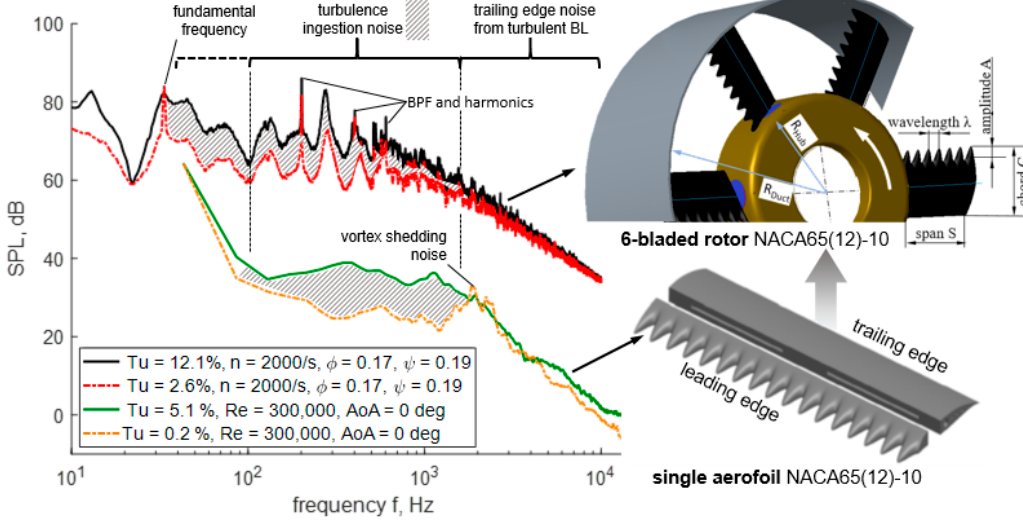
Figure 1. Juxtaposition of the sound pressure level SPL (Equation (6)) of a single NACA 65(12)-10 aerofoil vs. a 6-bladed axial fan, featuring the NACA 65(12)-10 as fan blades of span S [16]. Rotor blade chord C, serration amplitude A and wavelength λ downscaled by factor 2 at comparable blade incidence.